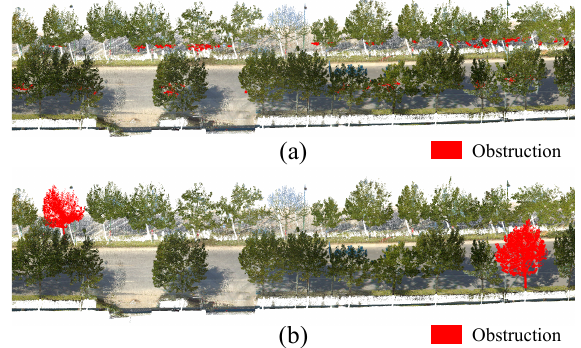
Figure 11. Results of different methods: (a) Our method, (b) Luoma's